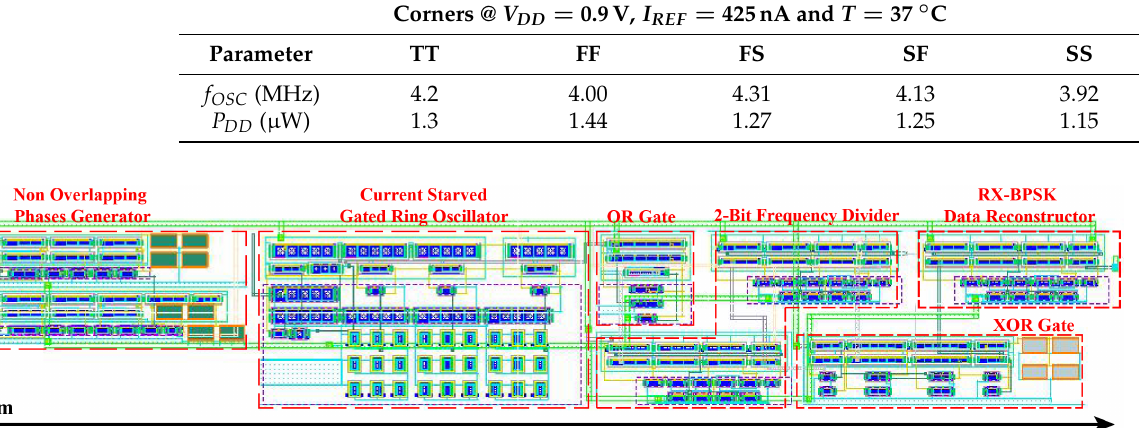
Figure 17. Top view of the proposed demodulator